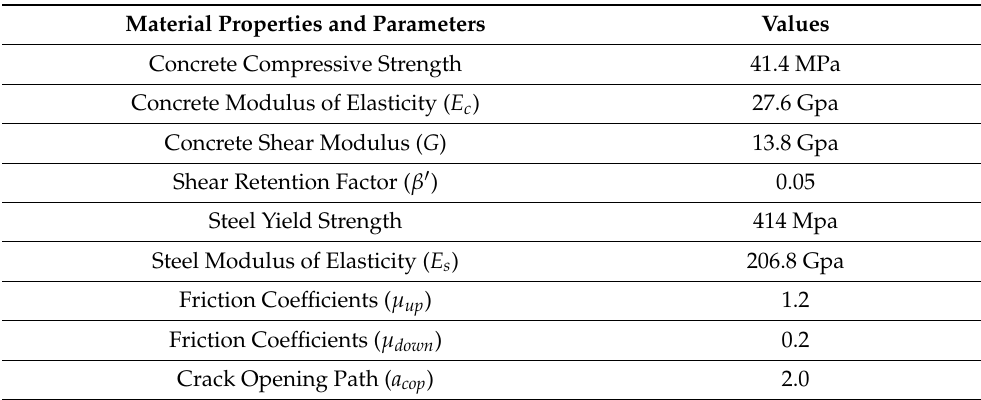
Table 6. Material properties and parameters for the base